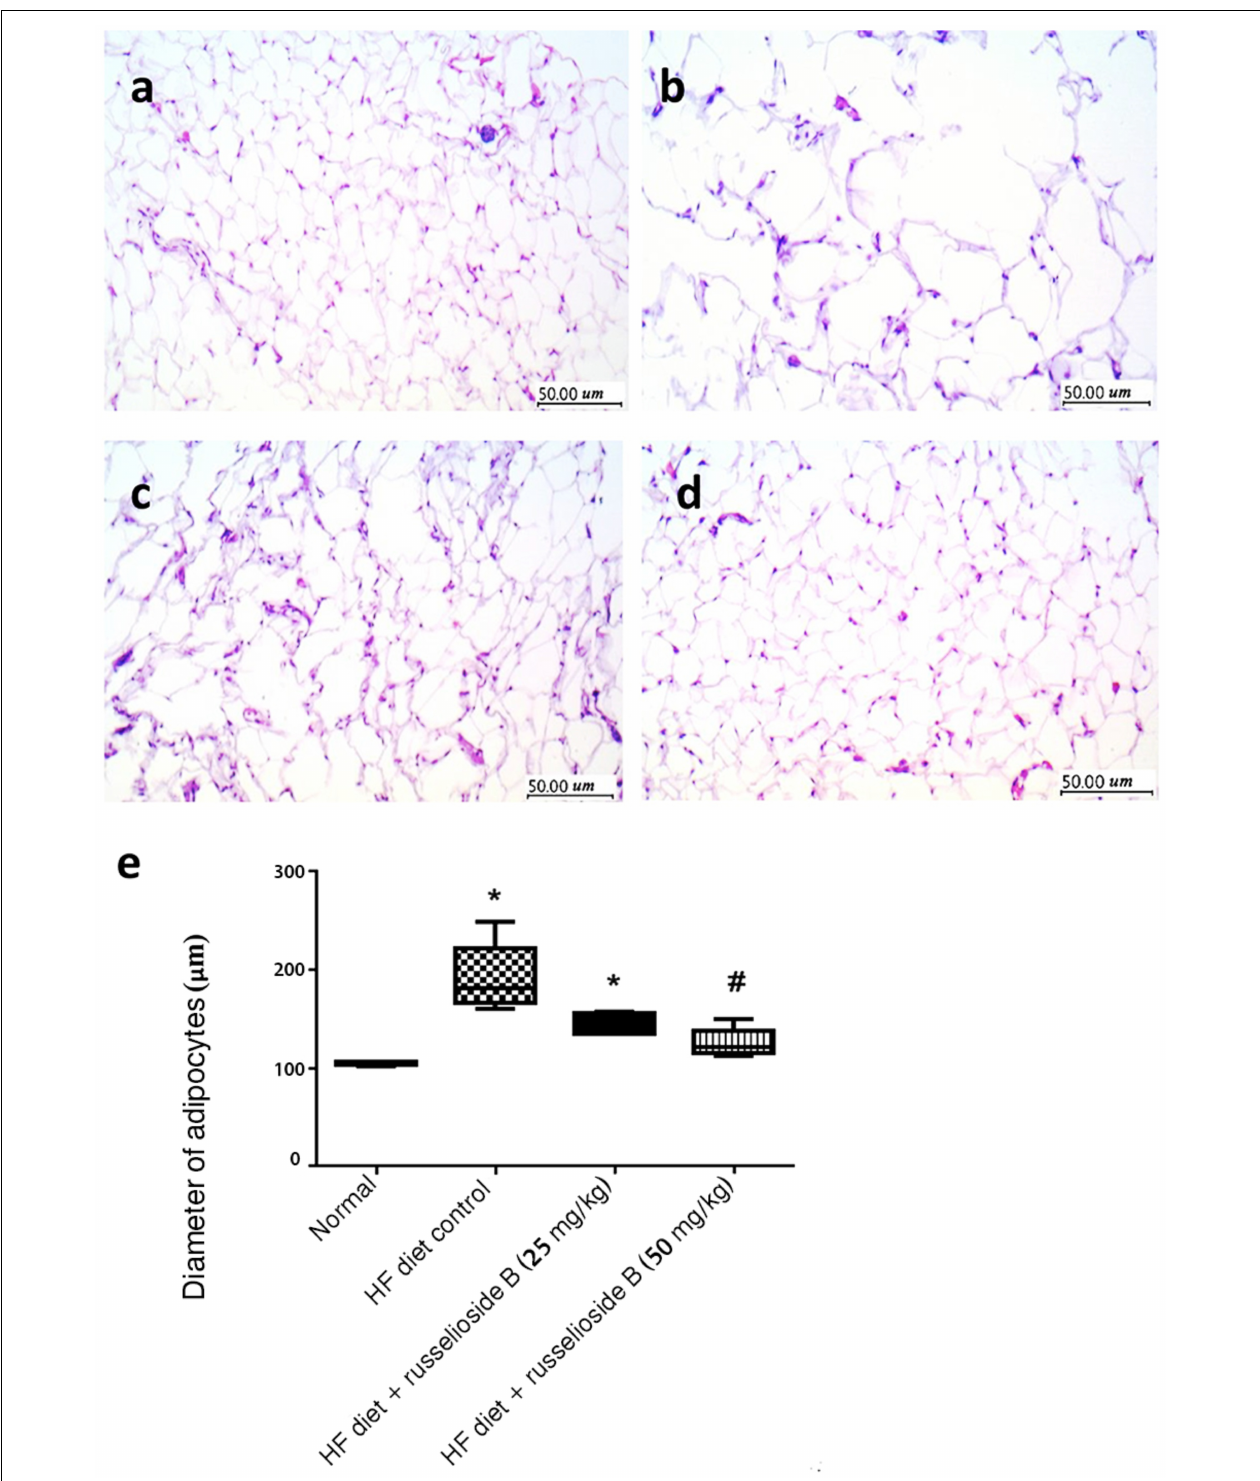
FIGURE 4 | Effect of russelioside B on the diameter of adipocyte spaces in the lumbar adipose tissue. (a) Tissue section from normal rat adipose tissue showing low-diameter adipocyte space; (b) tissue section from adipose tissue from HF diet control rats showing larger-diameter adipocyte spaces; (c, d) : tissue sections from adipose tissues from HF diet fed rats treated with RB at 25 and 50 mg/kg, respectively; and (e) : box plots showing the medians and quartiles for diameters ( µ m) of adipocyte spaces. ∗ significant versus normal group, # significant versus HF diet control group, and $ significant versus HF diet + russelioside B (25 mg/kg) group. Comparison was performed by non-parametric ANOVA followed by Dunn’s test at P <